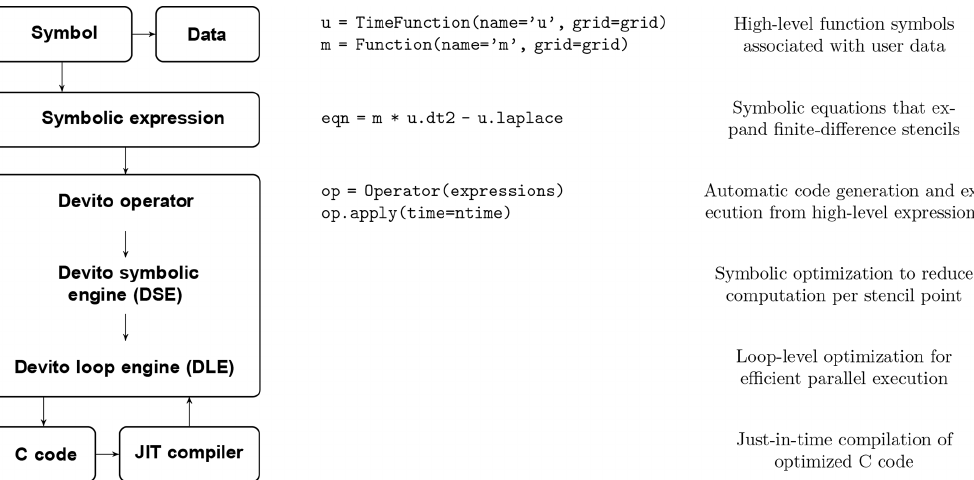
Figure 1. Overview of the Devito architecture and the associated example workflow. Devito’s top-level API allows users to generate symbolic stencil expressions using data-carrying function objects that can be used for symbolic expressions via SymPy. From this high-level definition, an operator then generates, compiles, and executes high-performance C code.